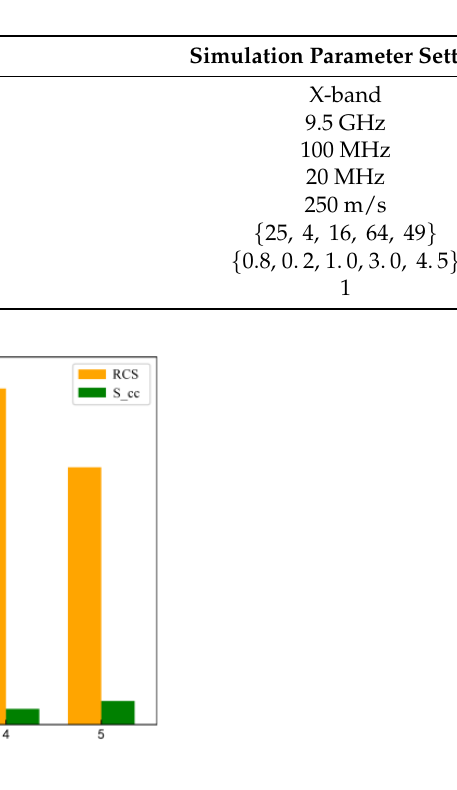
Figure 9. Environmental clutter and target impulse response.